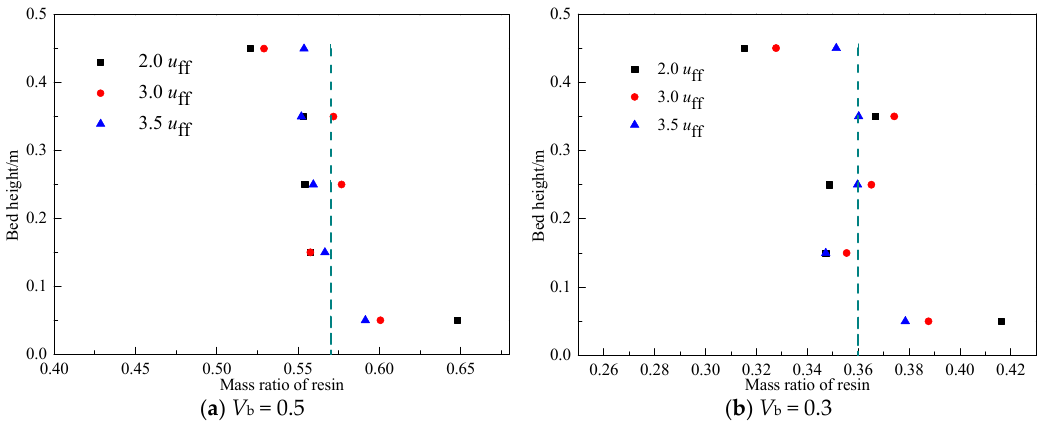
Figure 8. Mass concentration profiles of SS in the RA-SS systems.